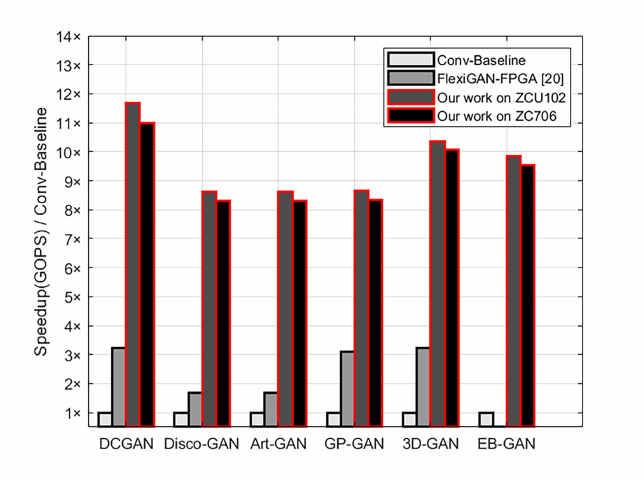
Figure 14. Comparison between our work and the prior work [20] on the speedup ratio against